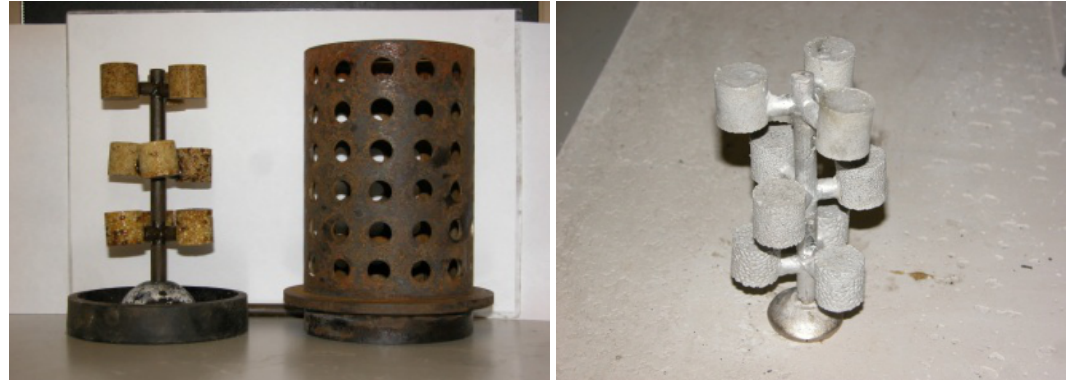
Figure 16. Wax tree, preforms and perforated steel flask (left) and infiltrated preforms after casting